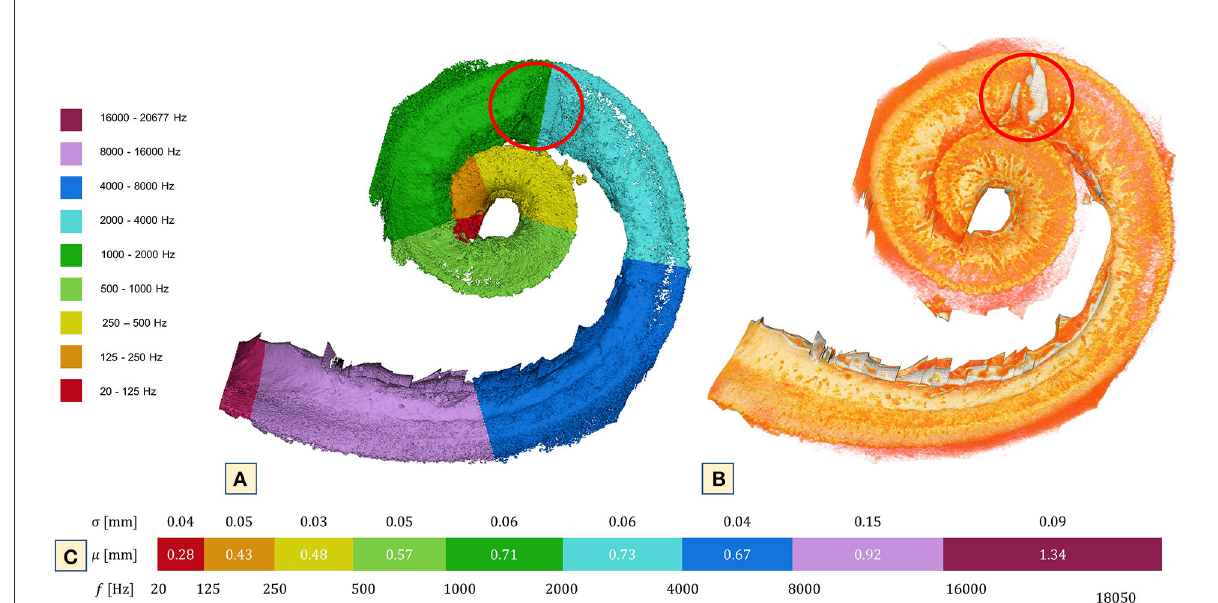
FIGURE7 3D reconstruction of the OSL at 4.46 µ m voxel size. (A) Tonotopic map of the cochlea using the OSL as reference and the bony formation at 2,000Hz. (B) Simple segmentation of the OSL (orange) and a clear view of the lithic process over the 2,000Hz (red circle). Note that only in that particular part of the OSL is it possible to see the bone formation. The region that corresponds to the CP was not included in this segmentation. Nonetheless, CL were present throughout its extension. (C) Mean and SD of cochlea width measured according to octave band